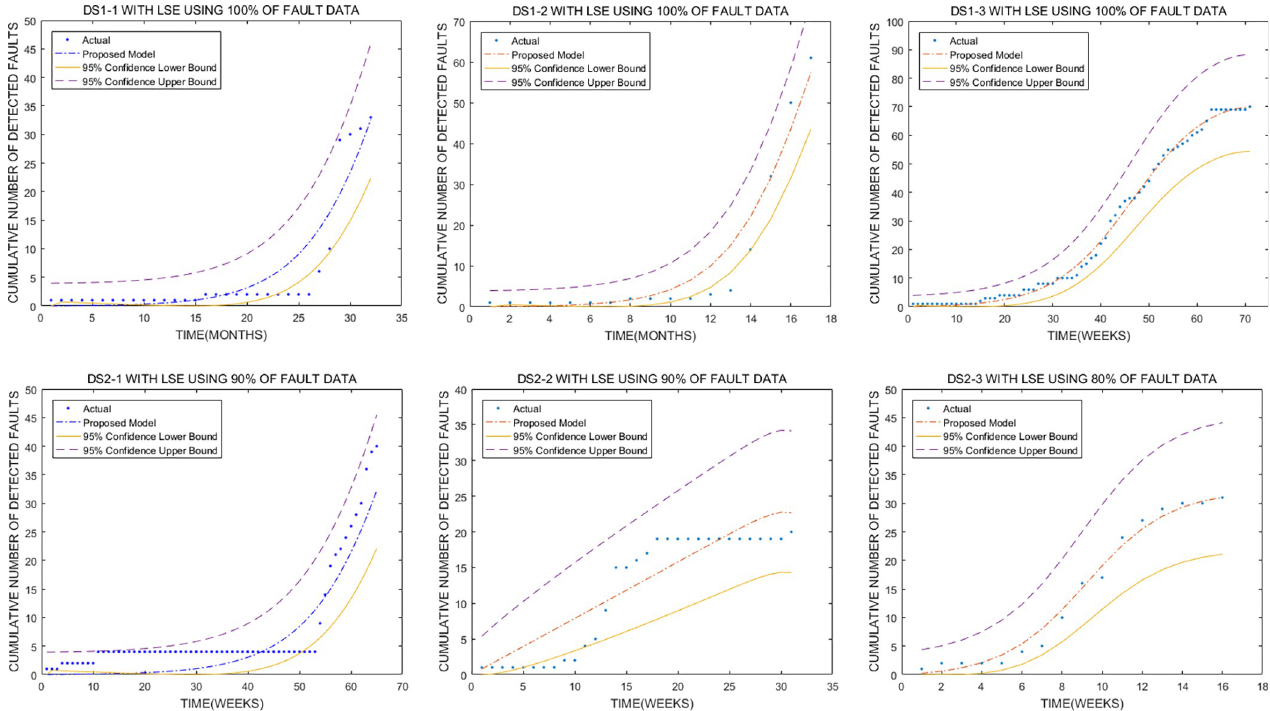
Fig 3. Plots of 95% confidence intervals using fault data (DS1 and DS2). (a), (b), and (c) represent 95% confidence intervals using 100% of fault data (STORM 1.0.1, STORM 1.0.2, and STORM 1.0.3), respectively. (d), (e), and (f) denote 95% confidence intervals using 90%, 90%, and 80% of fault data (OpenCMIS 0.4.0, OpenCMIS 0.5.0, and OpenCMIS 0.6.0), respectively.